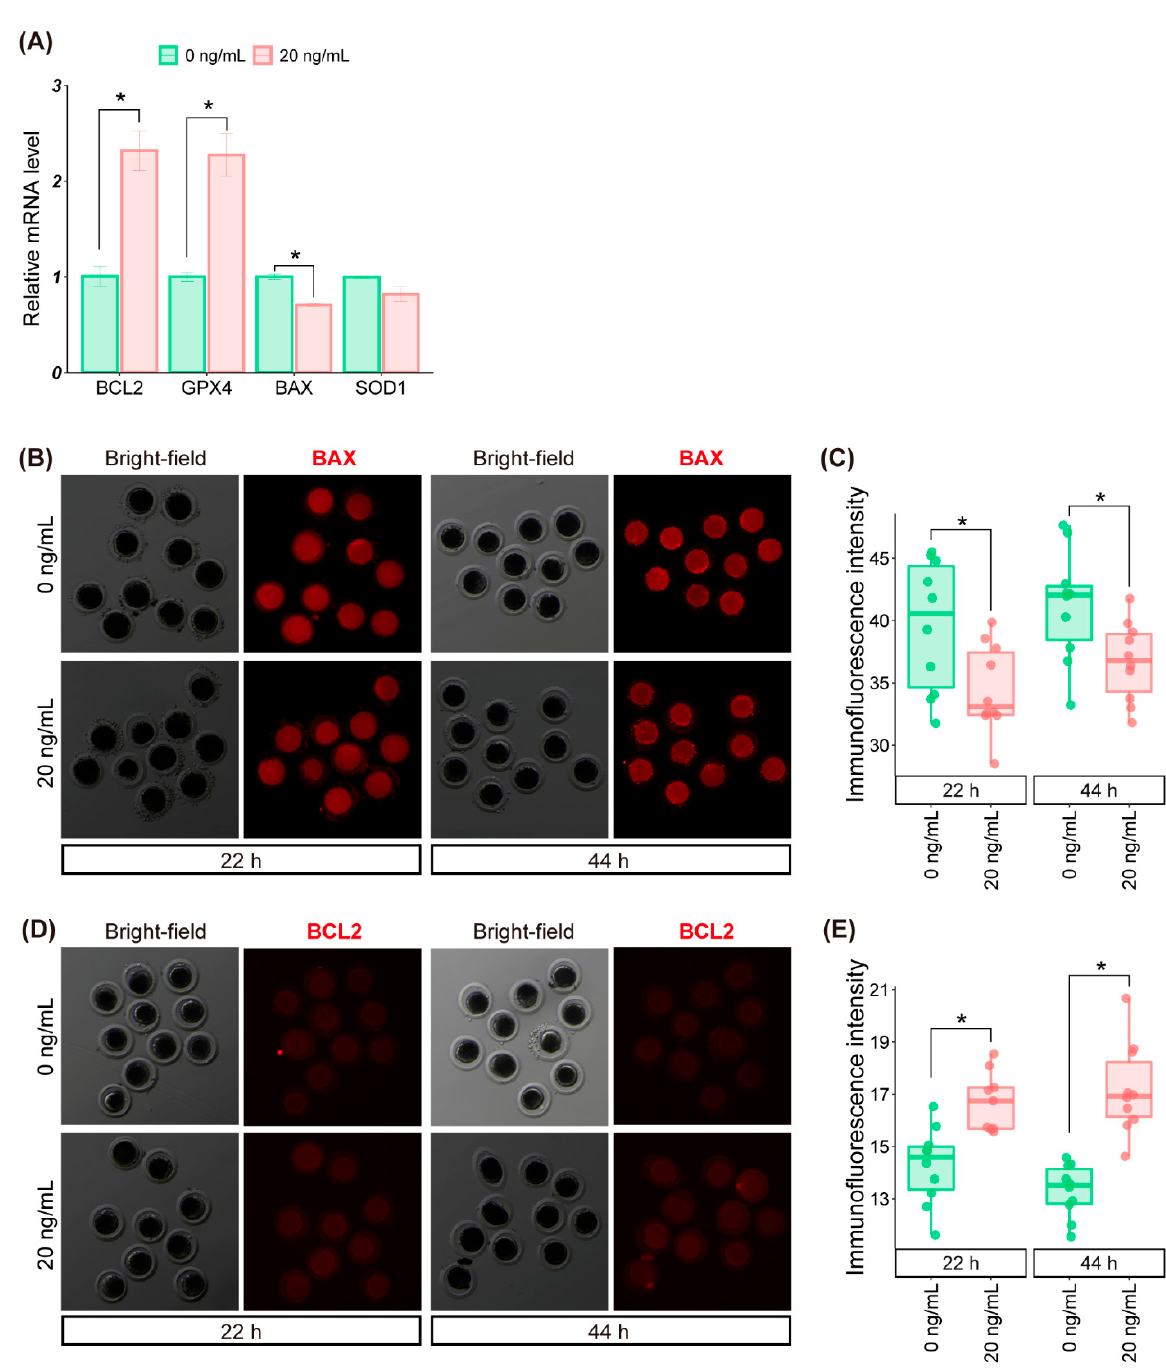
Figure 4. Expression of apoptosis and oxidative stress ‐ related genes in control and SDF1 ‐ treated pig oocytes. ( A ) Relative mRNA expression levels of apoptosis and oxidative stress ‐ related genes in porcine oocytes. BAX ( B ) and BCL2 ( D ) protein levels in pig oocytes. Quantification of BAX ( C ) and BCL2 ( E ) proteins in pig oocytes. “*” represents p < 0.05.